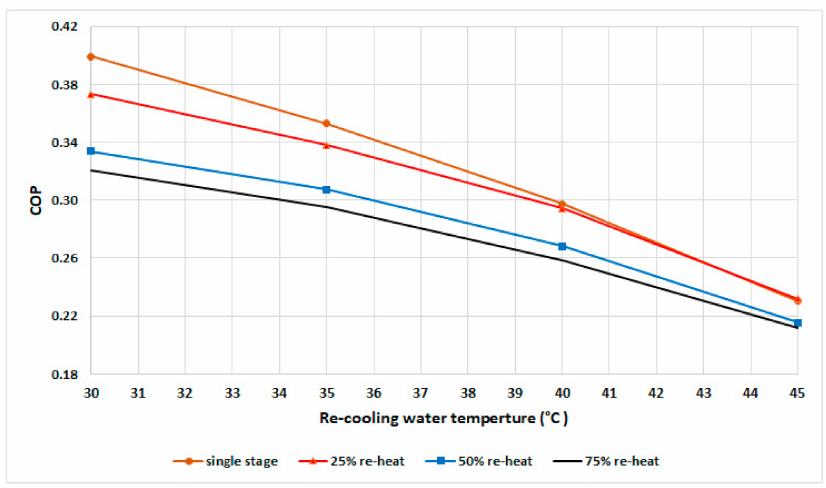
Figure 6. COP at various recooling-water temperatures and